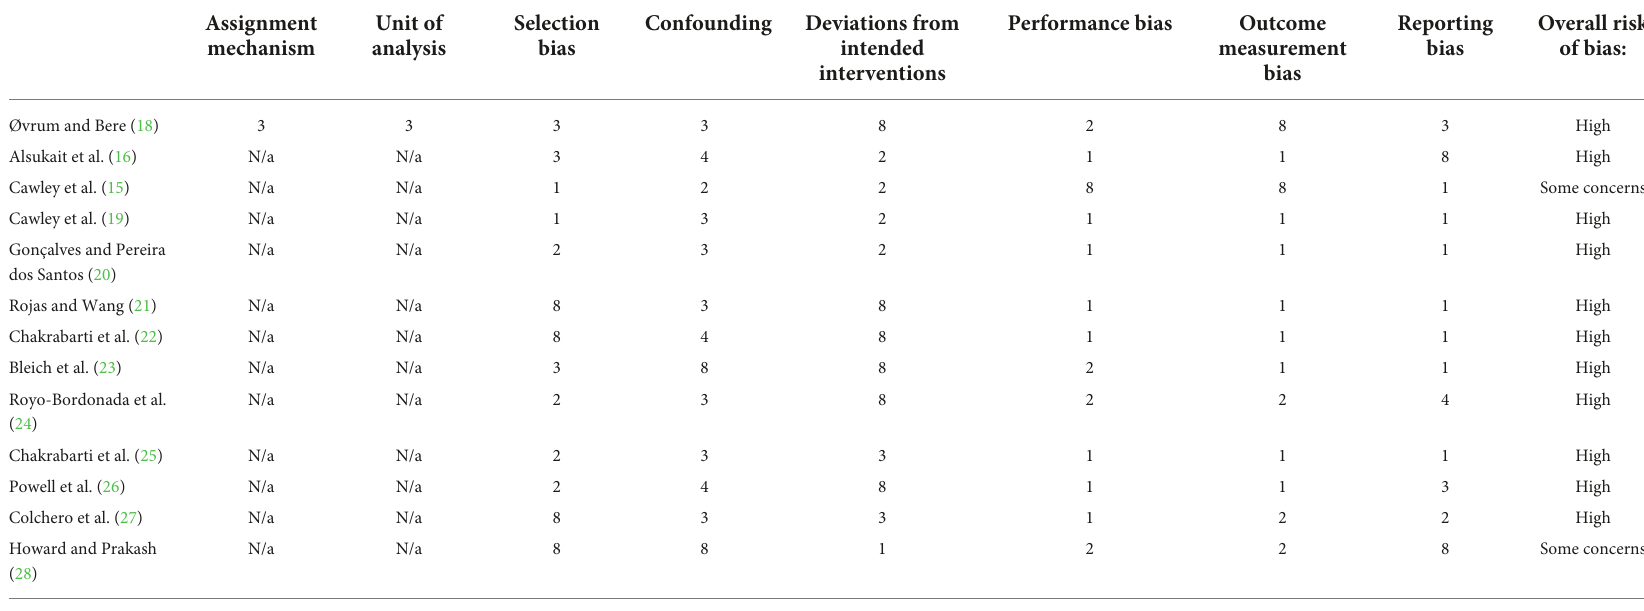
TABLE 4 Risk of bias of analyzed impact